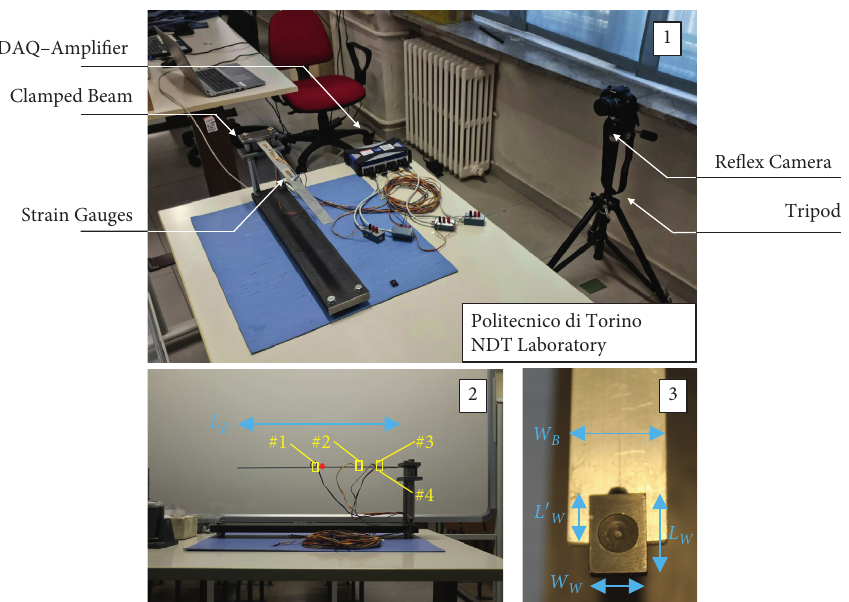
Figure 5: The third experimental setup (Politecnico di Torino). (1) The complete setup. (2) Point of view of the camera; the pixels selected for the virtual accelerometer are marked by the red dot (mid-length output channel) and the yellow squares (corresponding to the positions of the four strain gauges; #3 and #4 were applied, respectively, on the upper and lower side of the beam at the same distance from the clamped cross section). (3) Close up on the added mass (which falls during the video